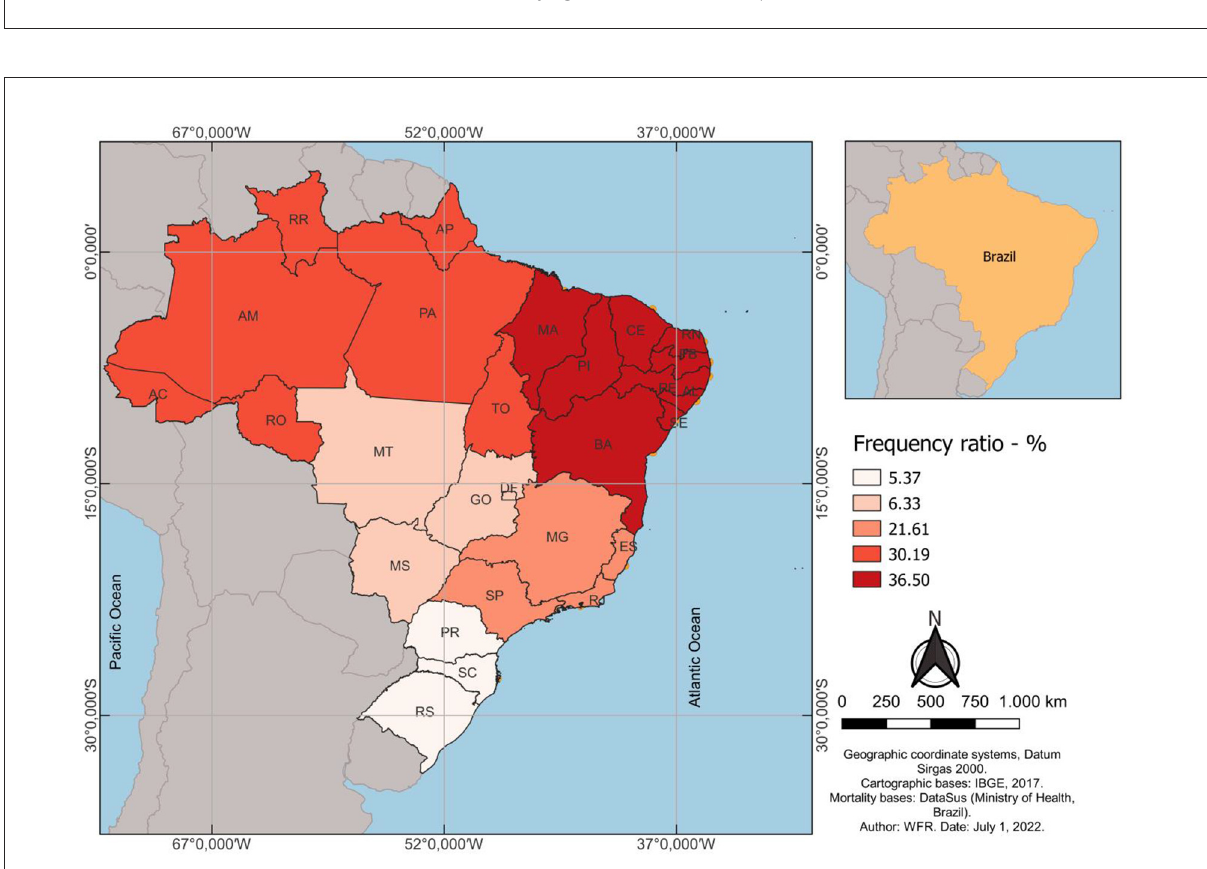
FIGURE4 Distribution of risk frequencies for the association of the pandemic by COVID-19 and mortality rates due to malnutrition in Brazil. After obtaining the mortality rates from COVID-19 and malnutrition, the relative frequencies (%) of the rates for each macro-region of Brazil (north, northeast, southeast, south and midwest. The arithmetic mean between the relative frequencies of each macro-region was used to generate the risk frequency estimator and plotted for the federative units of each macro-region. On the map, the more intense colors show regions with greater relationships between mortality rates. The database of the Brazilian Institute of Geography and Statistics (IBGE) was consulted to obtain cartographic data. The coordinate system used was the Datum Sirgas